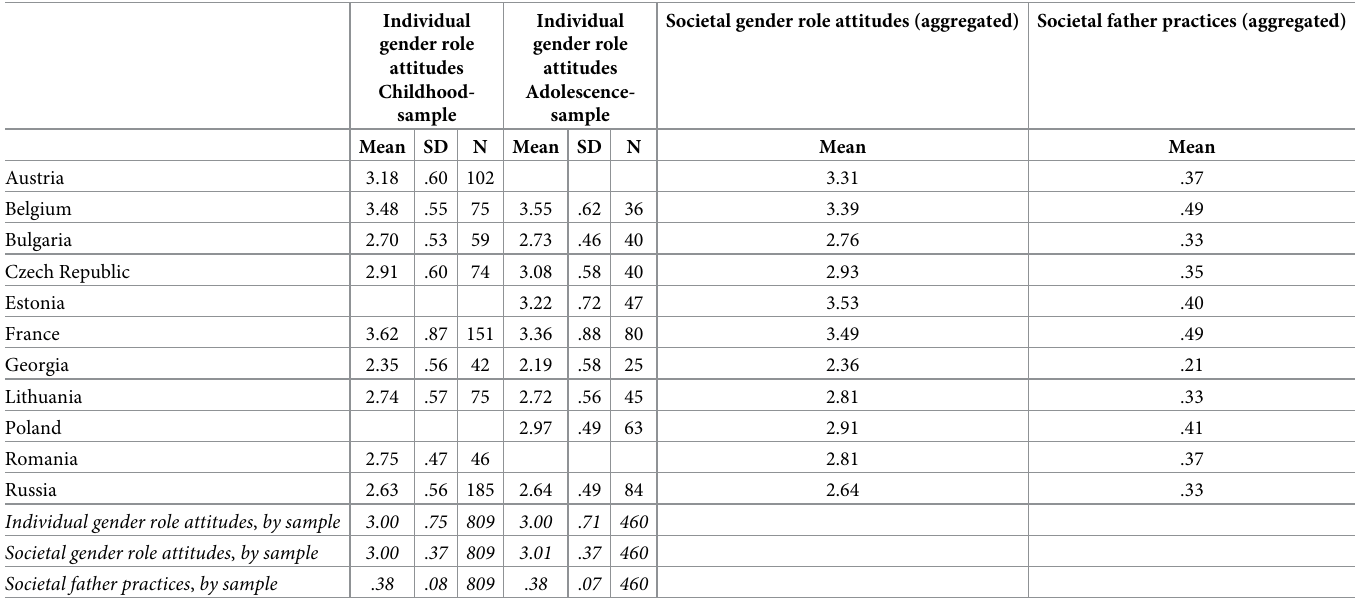
Table 2. Descriptive statistics of individual gender role attitudes for the childhood- and the adolescence-sample (means and standard deviations; complete cases) and aggregated societal gender role attitudes and father practices